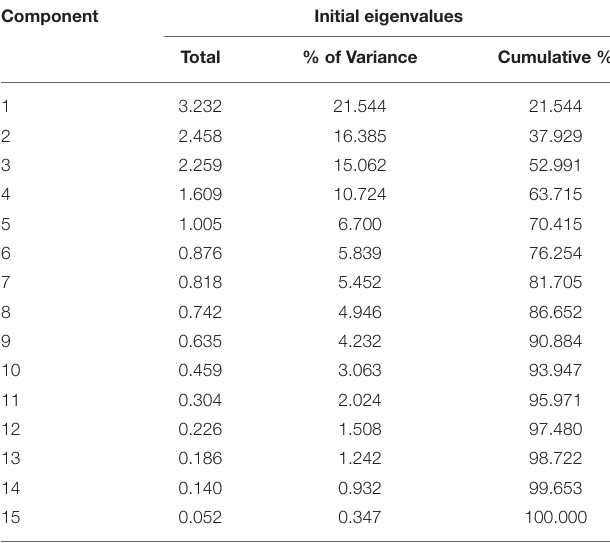
TABLE 6 | Eigen values explaining component contribution in total variance.